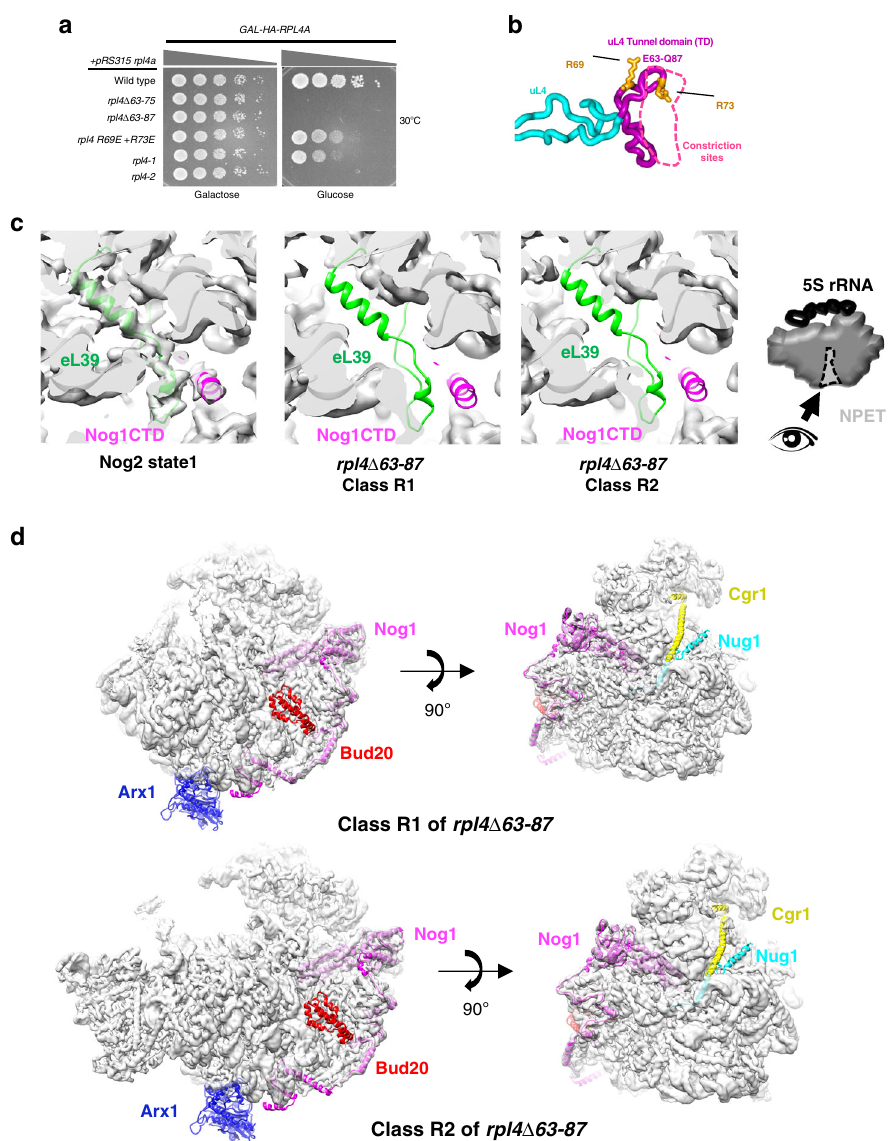
Fig. 2 Cryo-EM of rpl4 Δ 63 – 87 Nog2-associated mutant particles. a Deletion of the uL4 tunnel domain (aa 63 – 87) is lethal. Each strain contains GAL-RPL4 that can be turned off by shifting cells from galactose to glucose-medium, and a plasmid that is constitutively expressing an rpl4 mutant allele. The rpl4-1 and rpl4-2 mutantions are alanine scans of residues 63 – 68 and 69 – 74, respectively. Serial dilutions (1:10 to 1:10,000) of cultures were pipetted onto selective medium containing either galactose or glucose, incubated at 30 °C, and imaged after 3 days. b Diagram of the internal loop of uL4 (cyan), including the TD (purple) that extends into the NPET to help create the constriction sites (dotted pink line). Indicated arginine residues (orange) were mutated to glutamate. The TD forms the constriction sites in the NPET (pink dotted line). c Close up view of the exit of the NPET in wild-type Nog2 state 1 and rpl4 Δ 63 – 87 classes R1 and R2. Gray densities are not present in classes R1 and R2 in the spaces where eL39 and the Nog1 CTD should be. Thus, the exposed cartoon model indicates missing components. d View of rpl4 Δ 63 – 87 classes R1 and R2 from the subunit interface (left) and solvent side (right). Densities are fi tted to the atomic model of wild-type Nog2 state 1 (PDB: 3jct). Exposed cartoon models of Arx1 (blue), the Nog1 CTD (magenta), Bud20 (red), Cgr1 (yellow), and Nug1 (cyan) represent missing densities for each respective